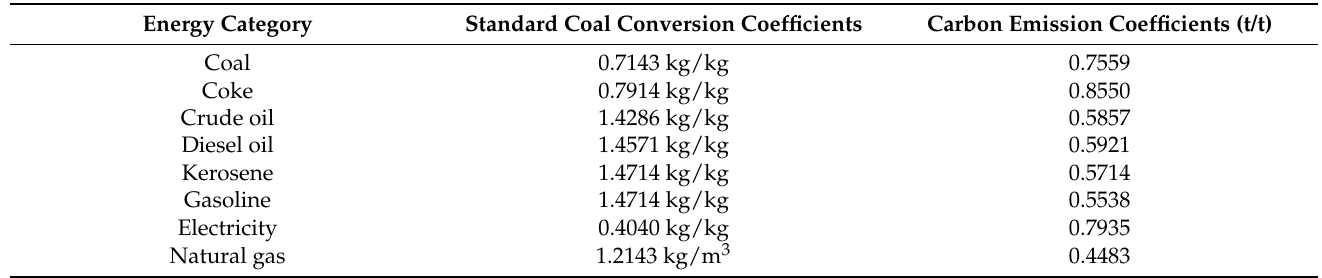
Table 1. Standard coal conversion coefficients and carbon emission coefficients of different energy